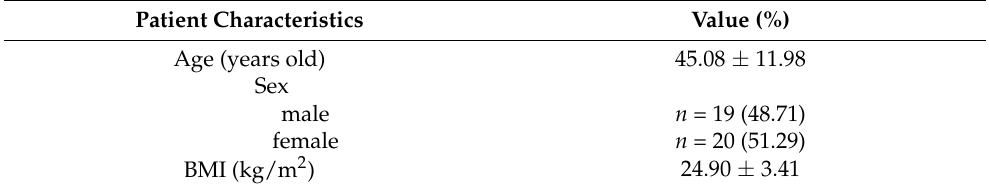
Table 1. Demographic and clinical characteristics of the